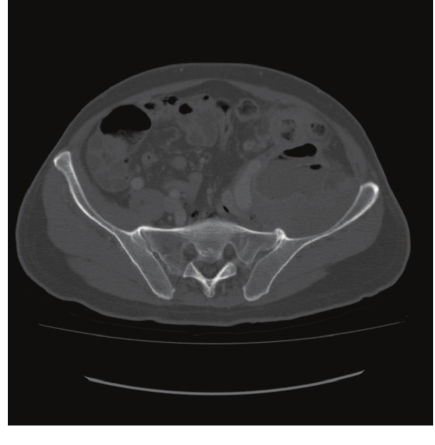
muscle, removal of the pus to culture examination, and the washing of the abscessual cavity with double drainage of the same. A metastasis surfacing the IV hepatic segment was